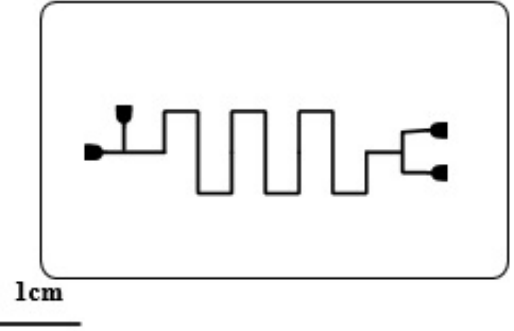
Figure 1. Microdroplet chip based on polydimethylsiloxane (PDMS) material .